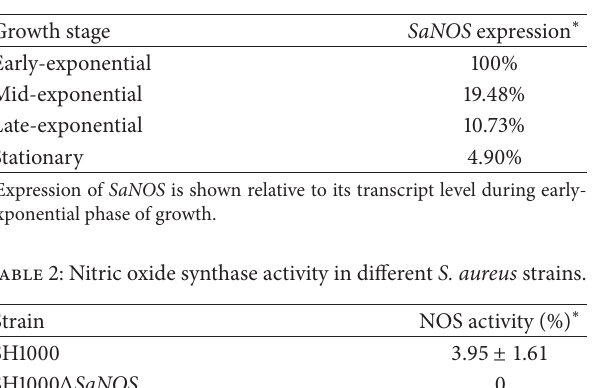
Table 1: Expression of SaNOS in S. aureus during different phases of growth.